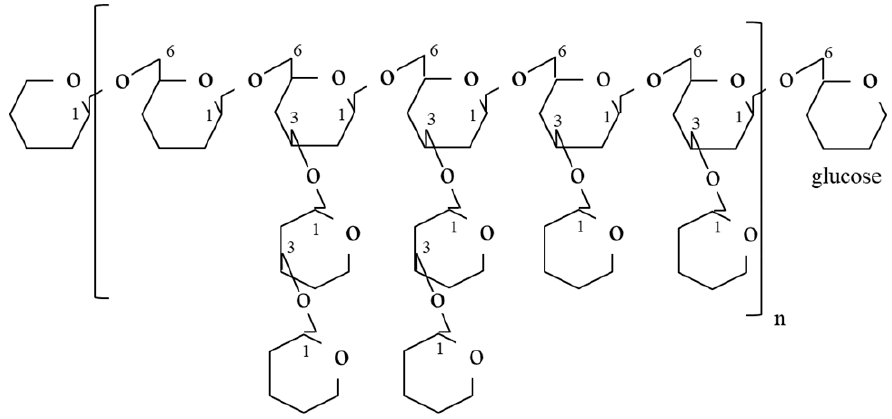
Figure 3. Typical structure of the D-fraction with (1 → 6)-glucan having a (1 → 3)-branched chain [49] .